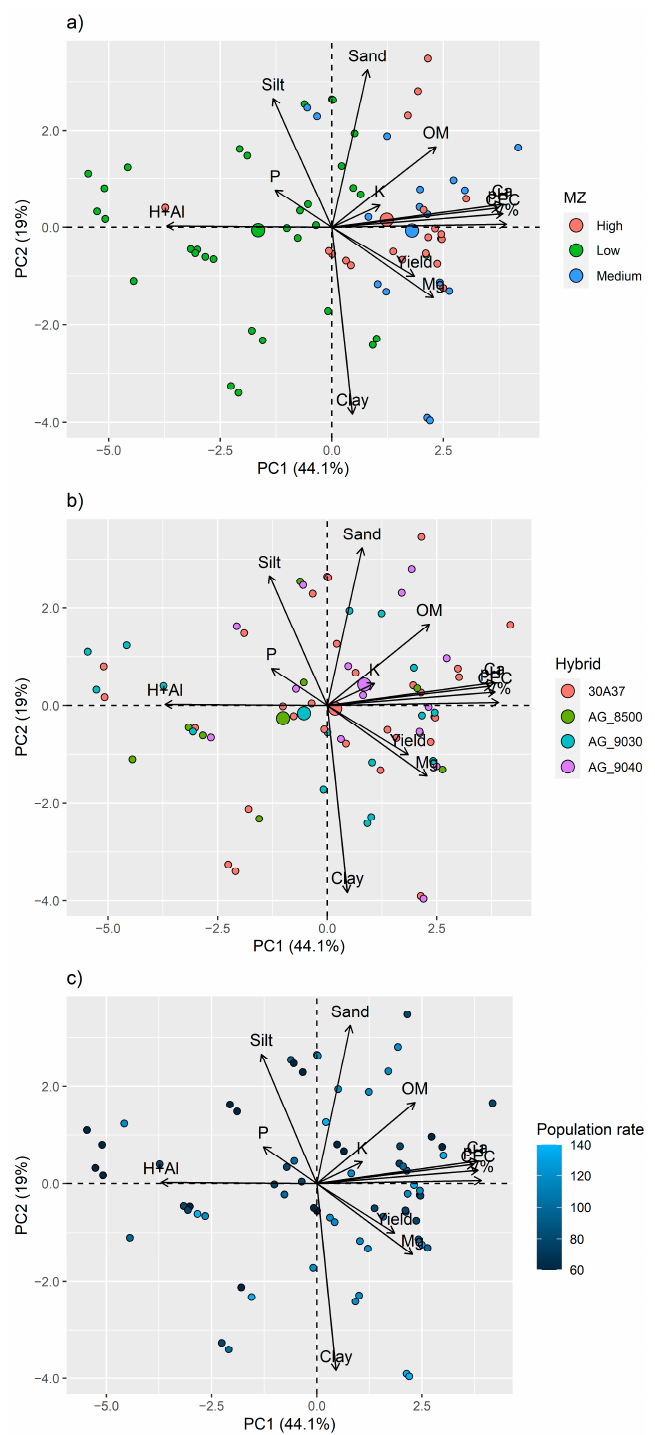
12 Figure 12. Principal component analysis (PCA) of soil attributes and maize yield in the first year of the experiment (2013) for classes of management zones ( a ), hybrids ( b ), and population rate ( c ). The biplot for the two first components suggests that the yield is related directly to Mg content. The variance in CEC, V, pH, and Ca attributes can be explained mainly by PC1. The contribution of these attributes is similar, with their partial overlapping along the positive direction of this component. On the other hand, variance in clay can be explained mainly by the negative direction of PC2. Moreover, the yield varies in the positive direction of PC1 and negative in PC2, with similar contributions from both components,